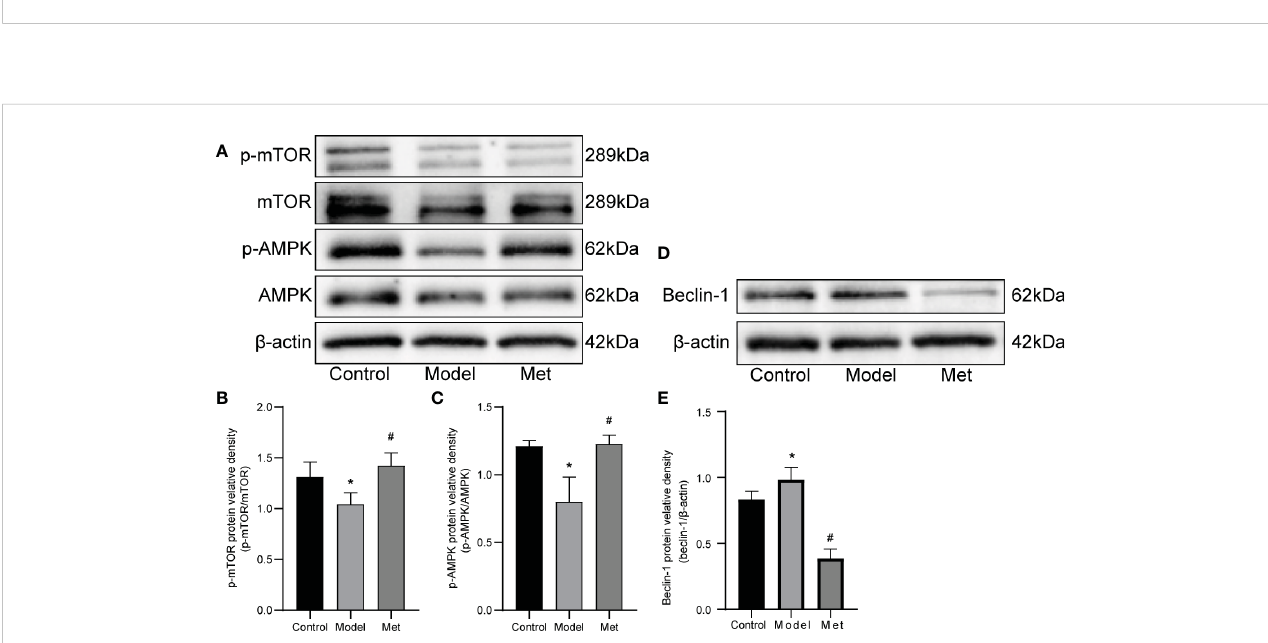
FIGURE 5 Metformin alters the expression of AMPK and mOTR in the ovaries of PCOS mice. (A) Western blot of mTOR, p-mTOR, AMPK, and p-AMPK. (B) Protein relative identity of p-mTOR. (C) Protein relative identity of p-AMPK. (D) Western blot of Beclin-1. (E) Protein relative identity of Beclin-1. Mean ± SEM, n=3* P < 0.05 vs control group; # P < 0.05 vs PCOS